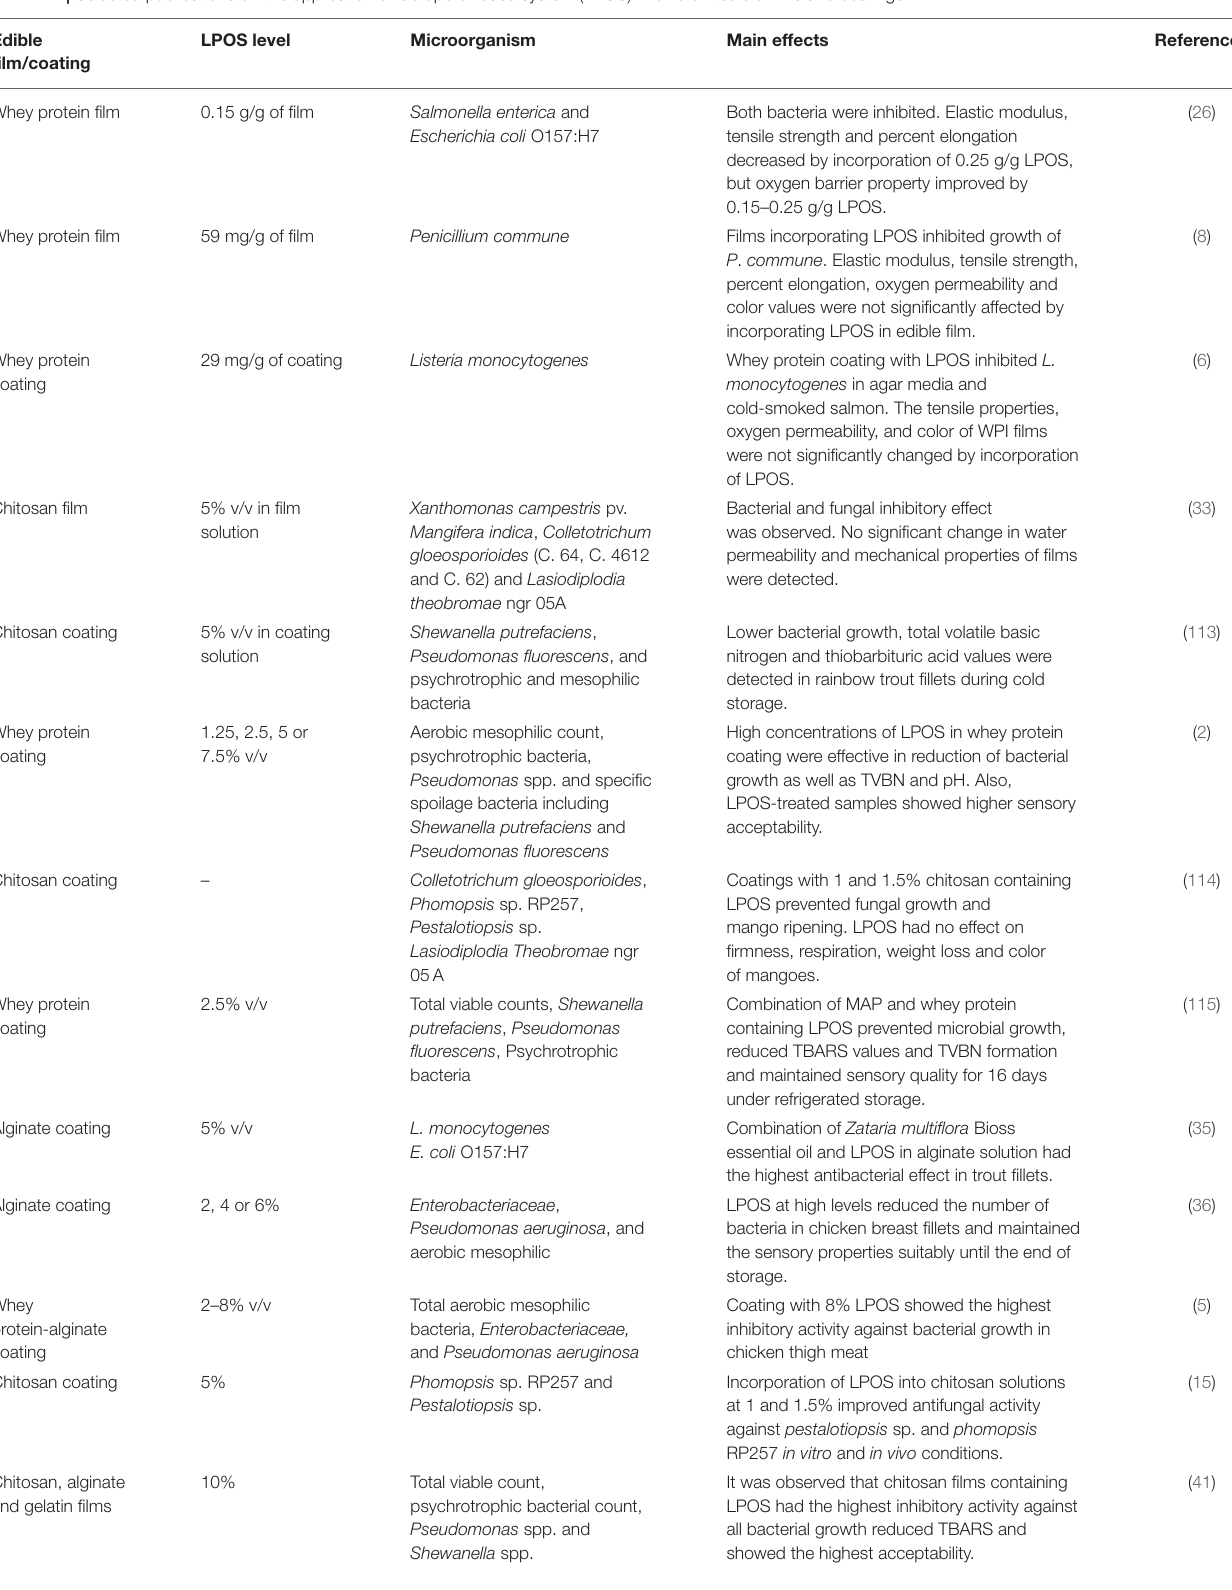
TABLE 2 | Selected publications on the application of lactoperoxidase system (LPOS) in different edible films and coatings. Edible